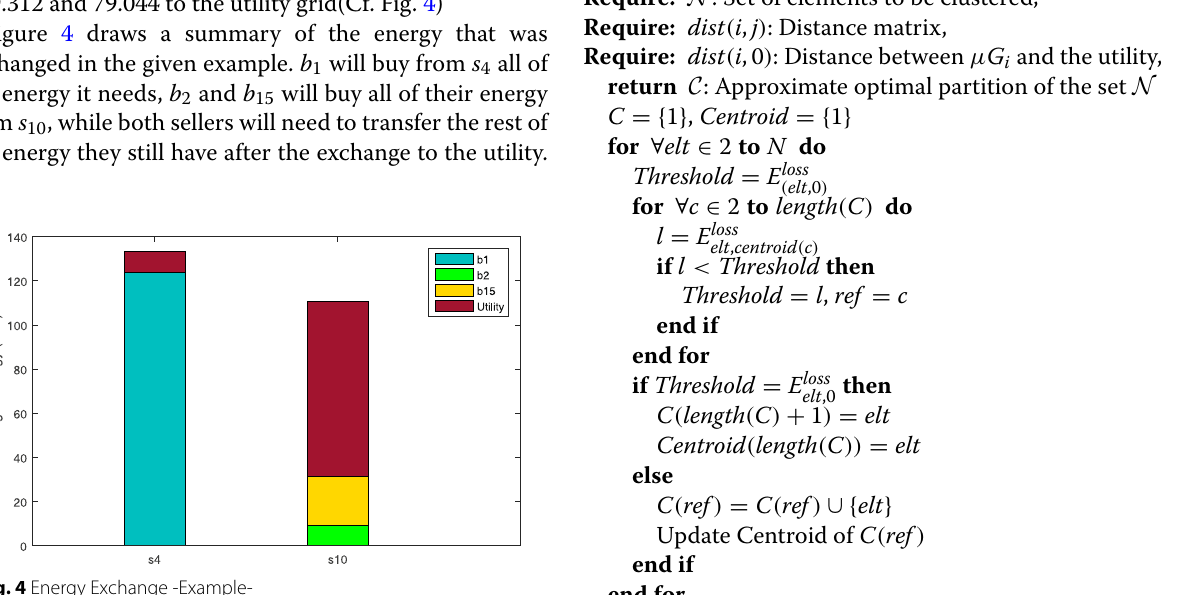
Fig. 4 Energy Exchange